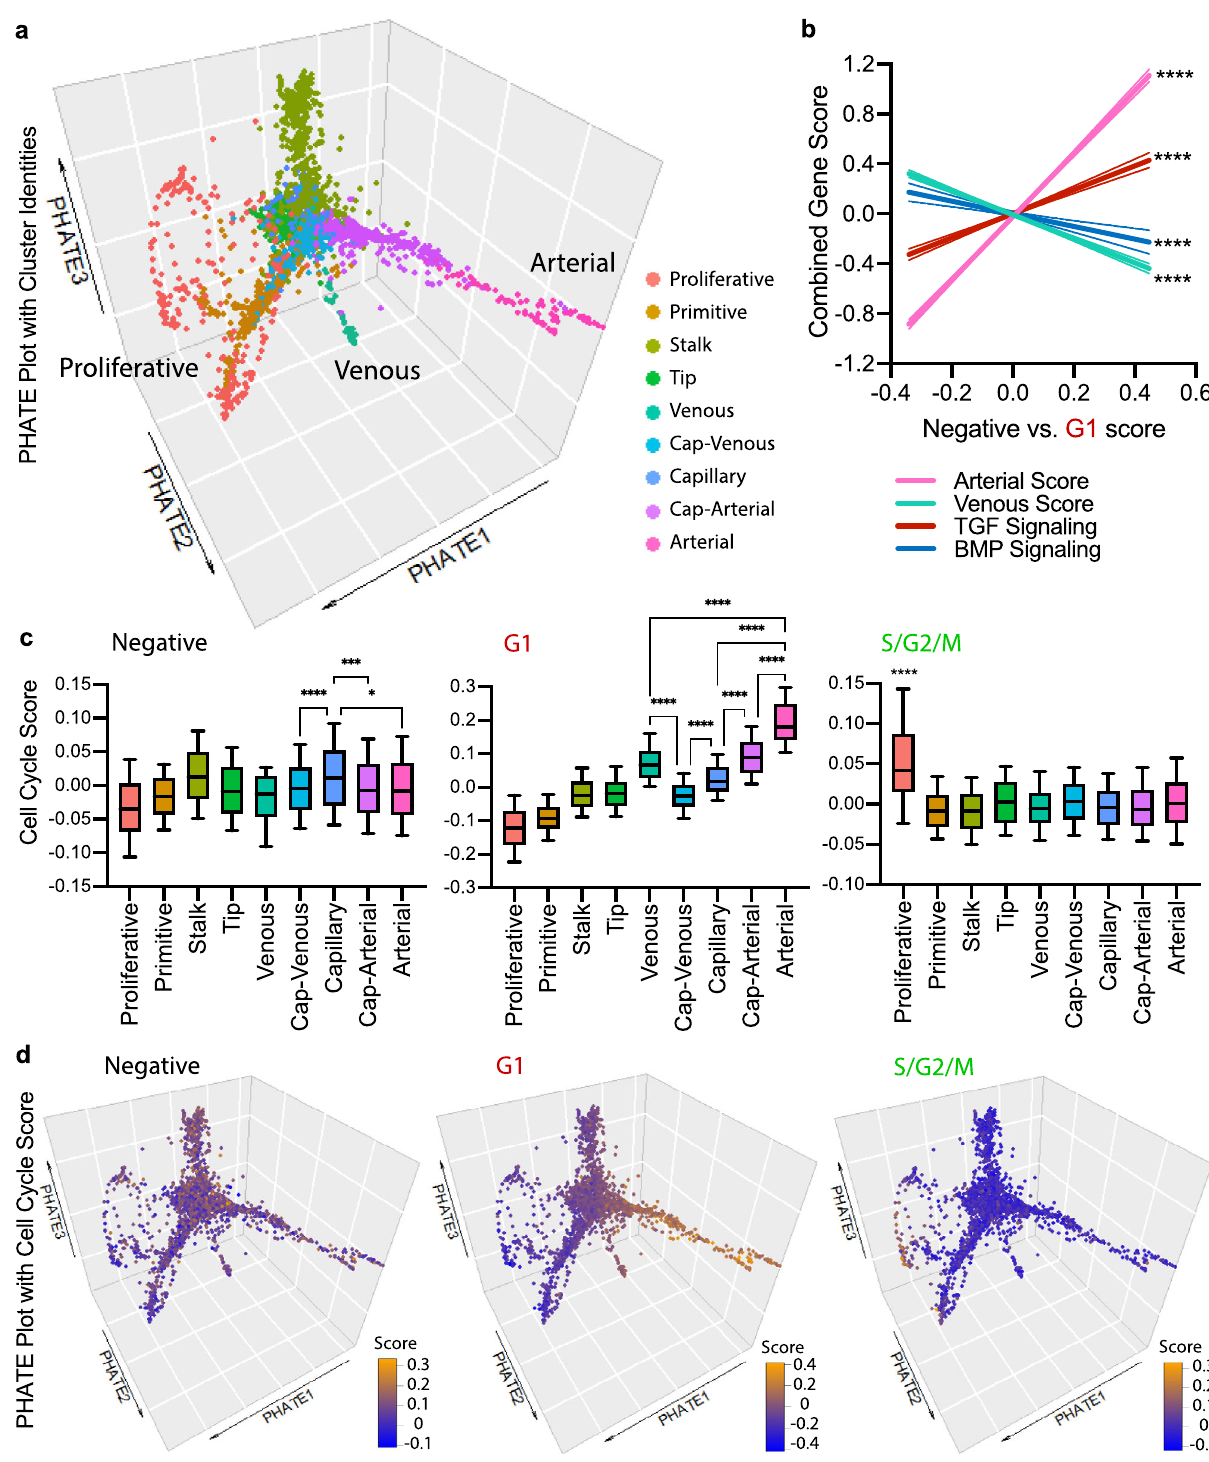
Fig. 4 | Differentiation trajectory analysis using PHATE with cell cycle scoring. a PHATE dimensionality reduction plot with clusters of endothelial cell popula- tions. b Linear regression of relative G1 score versus Arterial, Venous, TGF Signal- ing, and BMP Signaling Scores in each cell. c Cell cycle score of FUCCI-Negative, FUCCI-Red G1 and FUCCI-Green S/G2/M within clusters determined by genes upregulated in P6 R26FUCCI2aR retinal endothelial cell bulk RNA sequencing